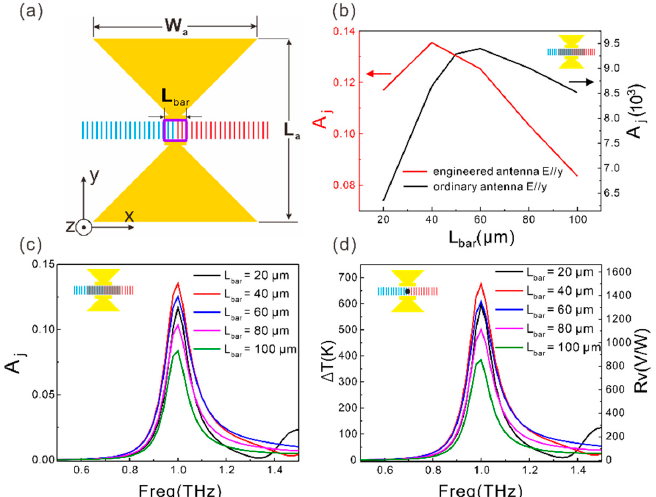
Figure 3. ( a ) Schematic diagram of modeling a bowtie antenna as a resonator using coupled mode theory. ( b ) Electric field enhancement distributions (log(| E |/| E 0 |)) on the x - y cross section at the center of the SWCNT film ( z = 1 µ m) integrated with the bowtie antenna at 1 THz for y -polarization. ( c ) Schematic diagram of the engineered antenna integrated SWCNT film. Each wing couples with its image and induces a magnetic dipole. ( d ) Same as ( b ) for the SWCNT film integrated with an engineered antenna (with bottom metal plane). ( e ) Electromagnetic field distribution of the engineered antenna integrated SWCNT film on a y-z cross section at x = 0. ( f ) A j as a function of the thickness of the insulator spacer in the engineered antenna integrated SWCNT film for y -polarization at 1 THz. The junction area is defined as a 5 µ m × 100 µ m × 2 µ m box at the center of the SWCNT film, as shown by the gray shade in the inset. E 0 in ( b , d ) denotes the electric field of the incident Gaussian beam at the junction.